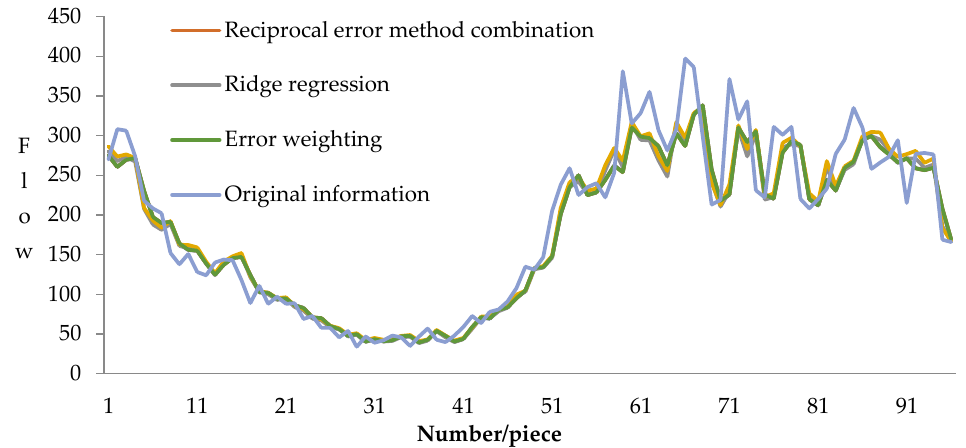
Figure 13. The single model error